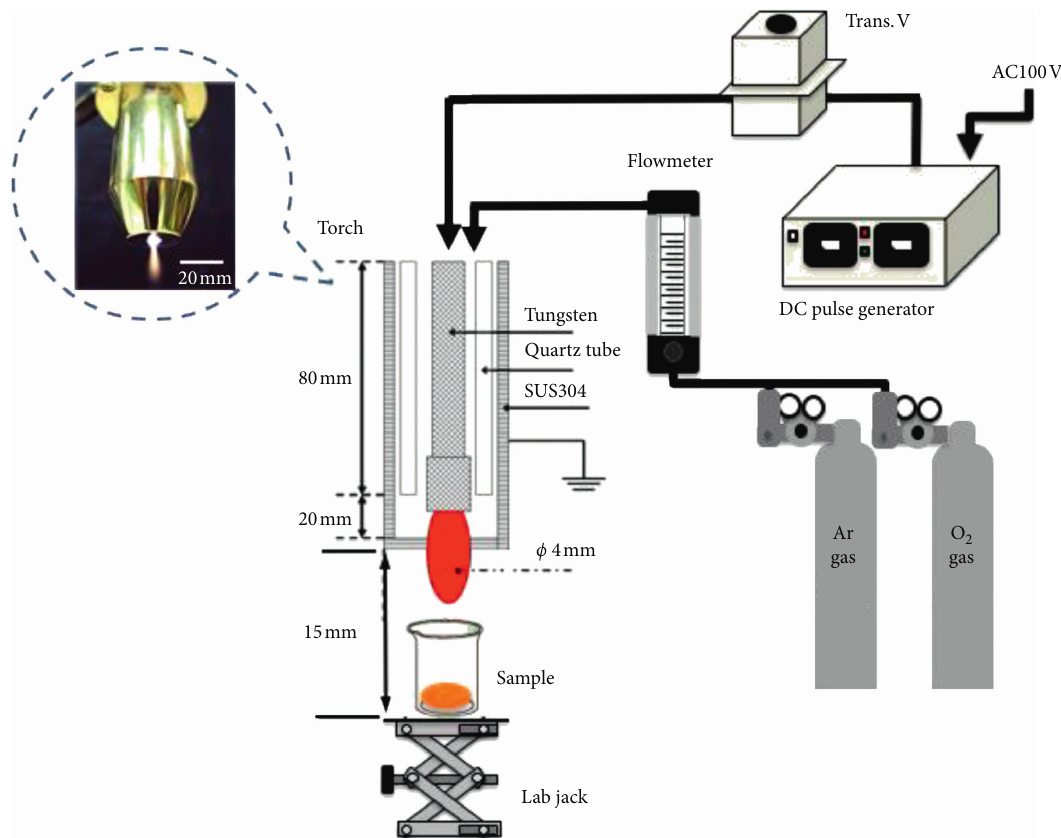
Figure 1: Schematic of the experimental setup.